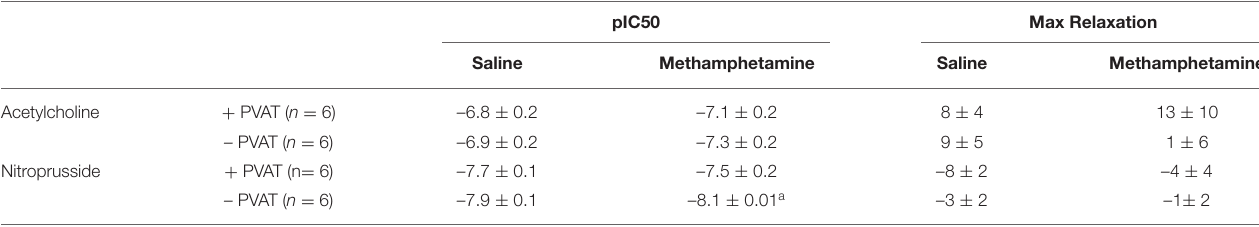
TABLE 2 | Acetylcholine- and nitroprusside-induced relaxation responses in aortas isolated from adult female rats that were exposed to fetal saline or methamphetamine (5 mg/kg/day) throughout the gestational period.